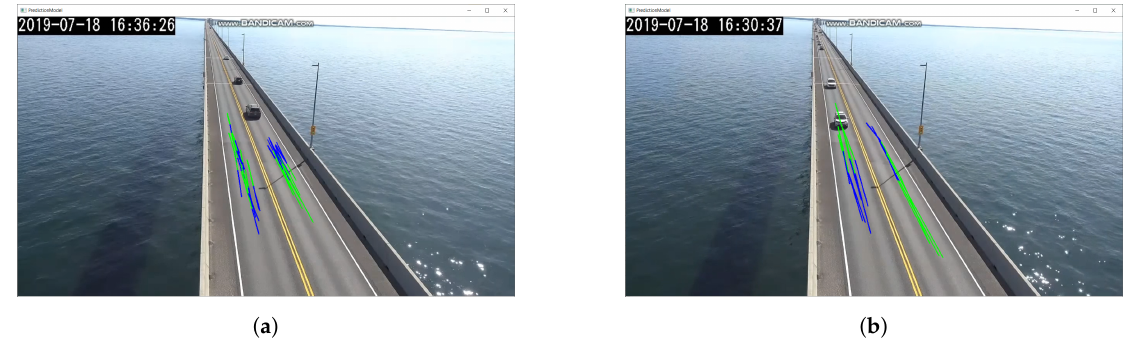
Figure 12. Prediction model visualizing the driving paths on the Confederation Bridge in Canada. ( a , b ) depict request intervals of 250 ms and 500 ms